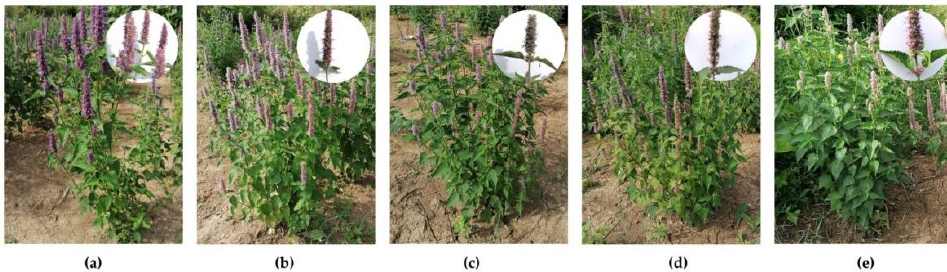
Figure 2. Aspects from the field with the Agastache species studied: ( a ) A. scrophulariifolia ; ( b ) A. rugosa ; ( c ) A. foeniculum ; ( d ) A. rugosa ‘After Eight’; ( e ) A. mexicana (original).